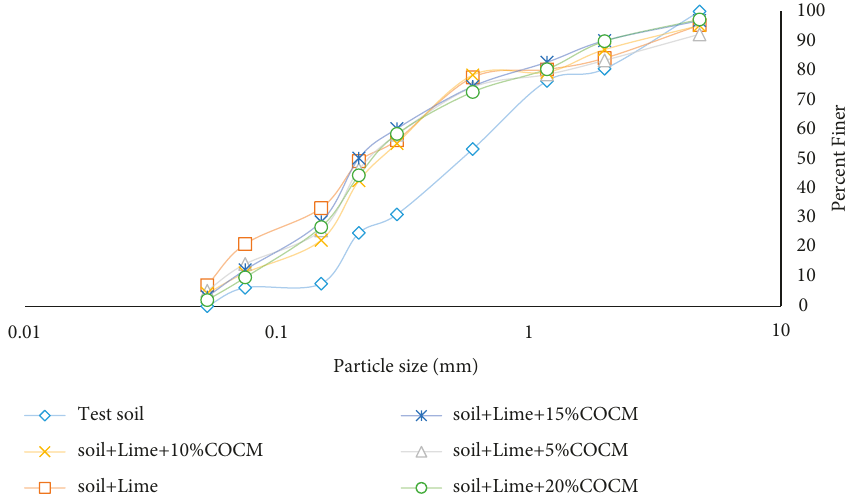
Figure 2: Particle size distribution plot.